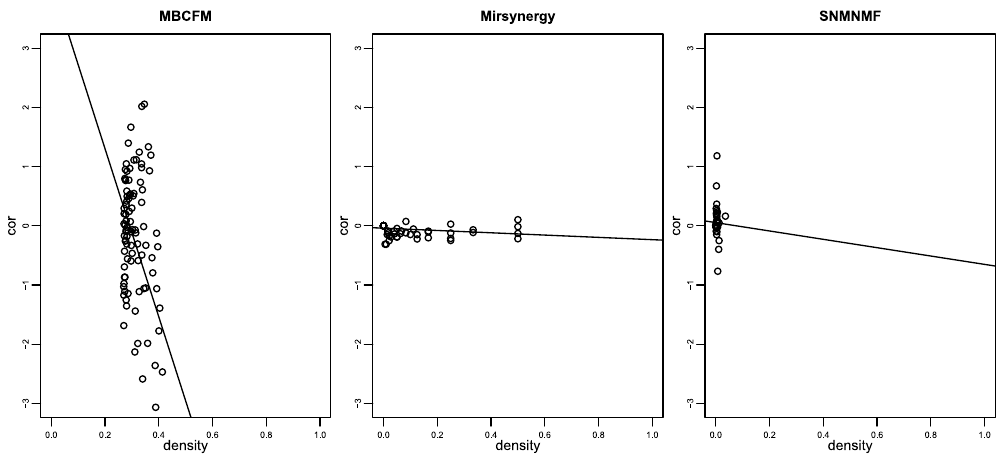
Figure 4. The distributions between density and anti-correlation for modules detected by MBCFM, Mirsynergy and SNMNMF. Large number of anti-correlation values of the modules detected by Mirsynergy are close to zero. Lots of density values of the modules detected by SNMNMF are also close to zero.